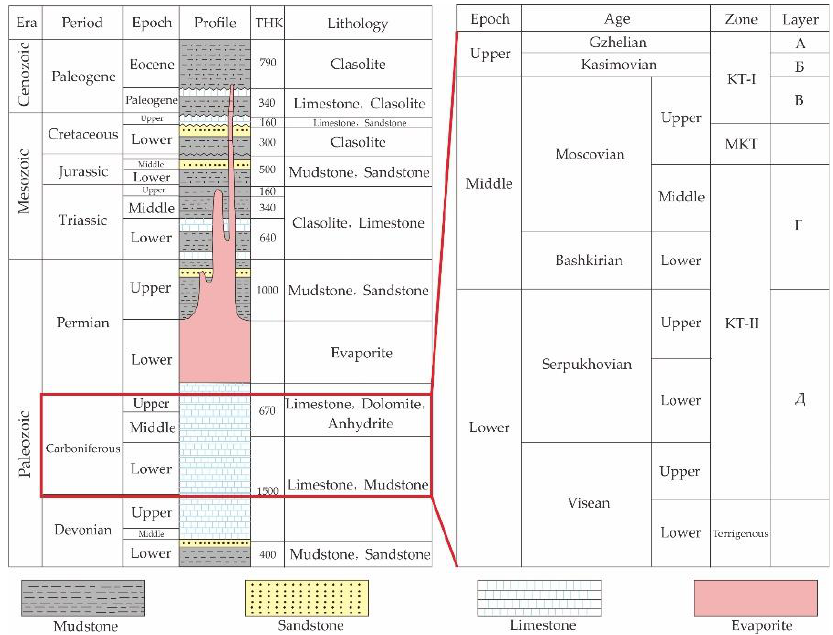
Figure 3. Comprehensive stratigraphic bar chart of the North Truva Oilfield. The main oil producing layers of the North Truwa Oilfield are located in the Middle and Upper Carboniferous, which can be divided into the KT-I oil layer and KT-II oil layer. The average thickness of the KT-I oil layer and the KT-II oil layer is 150 m and 230 m, respectively.